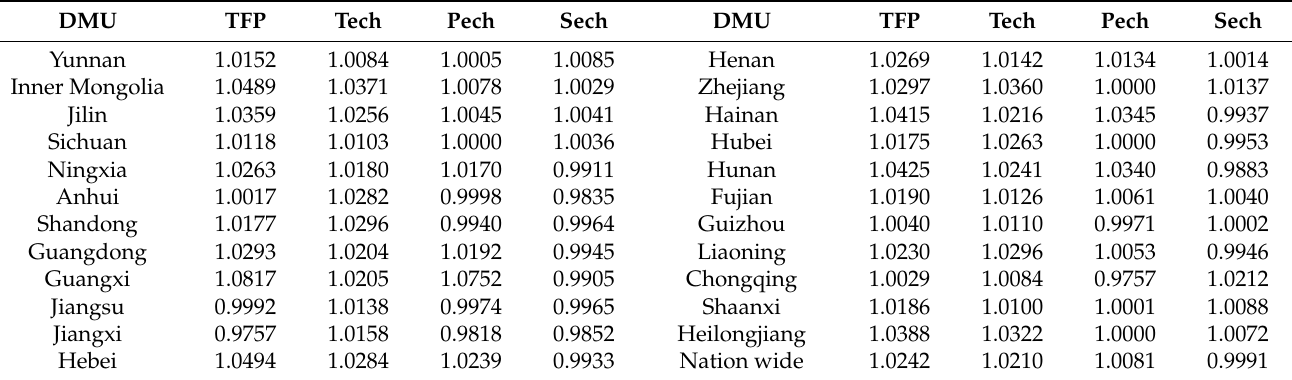
Table 3. Production Efficiency and Decomposition of Rice in 23 Major Rice Production Provinces in China from 2007 to 2018.